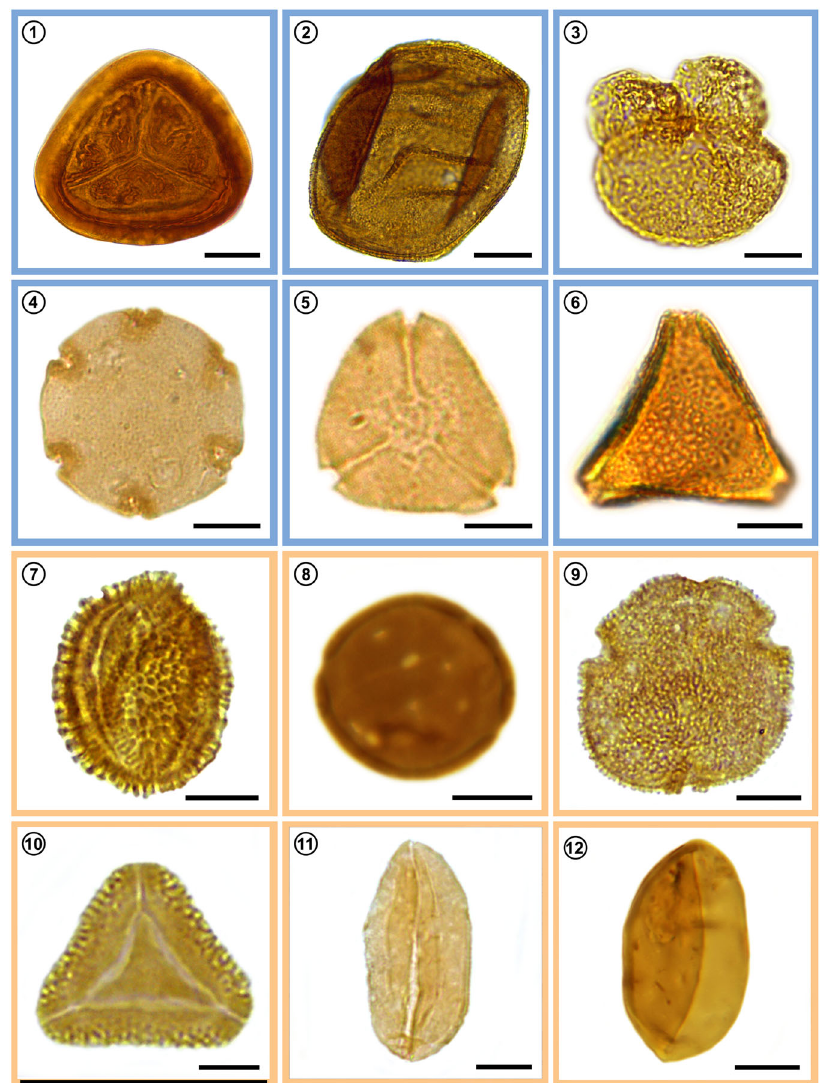
Fig. 8 Selected spore-pollen species from the Eocene of southern South America. (1 – 6) Gondwanic elements (blue square); (7 – 12) Tropical elements (orange square). (1) Cyatheacidites annulatus , sample 32 V18(1); (2) Araucariacites australis , sample 14 J44(2); (3) Podocarpidtes elegans , sample 28N41(4); (4) Nothofagidites rocaensis , sample 17 E40(1); (5) Myrtaceidites verrucosus , sample 14 H38(3); (6) Propylipollis pseudomoides , sample 19C22(1); (7) Ilexpollenites anguloclavatus , sample 13N57(4); (8) Perisyncolporites pokornyi , sample 3 I12(3); (9) Bombacacidites isoreticulatus , sample 16 Y39(2); (10) Cupaneidites insulares , sample 19 D13(4); (11) Arecipites regio , sample 3 R40(1); (12) Psilamonocolpites medius , sample 6 S31(1). Scale bar is 10 μ m. Taxonomic names are followed by the slide number and England Finder coordinates.